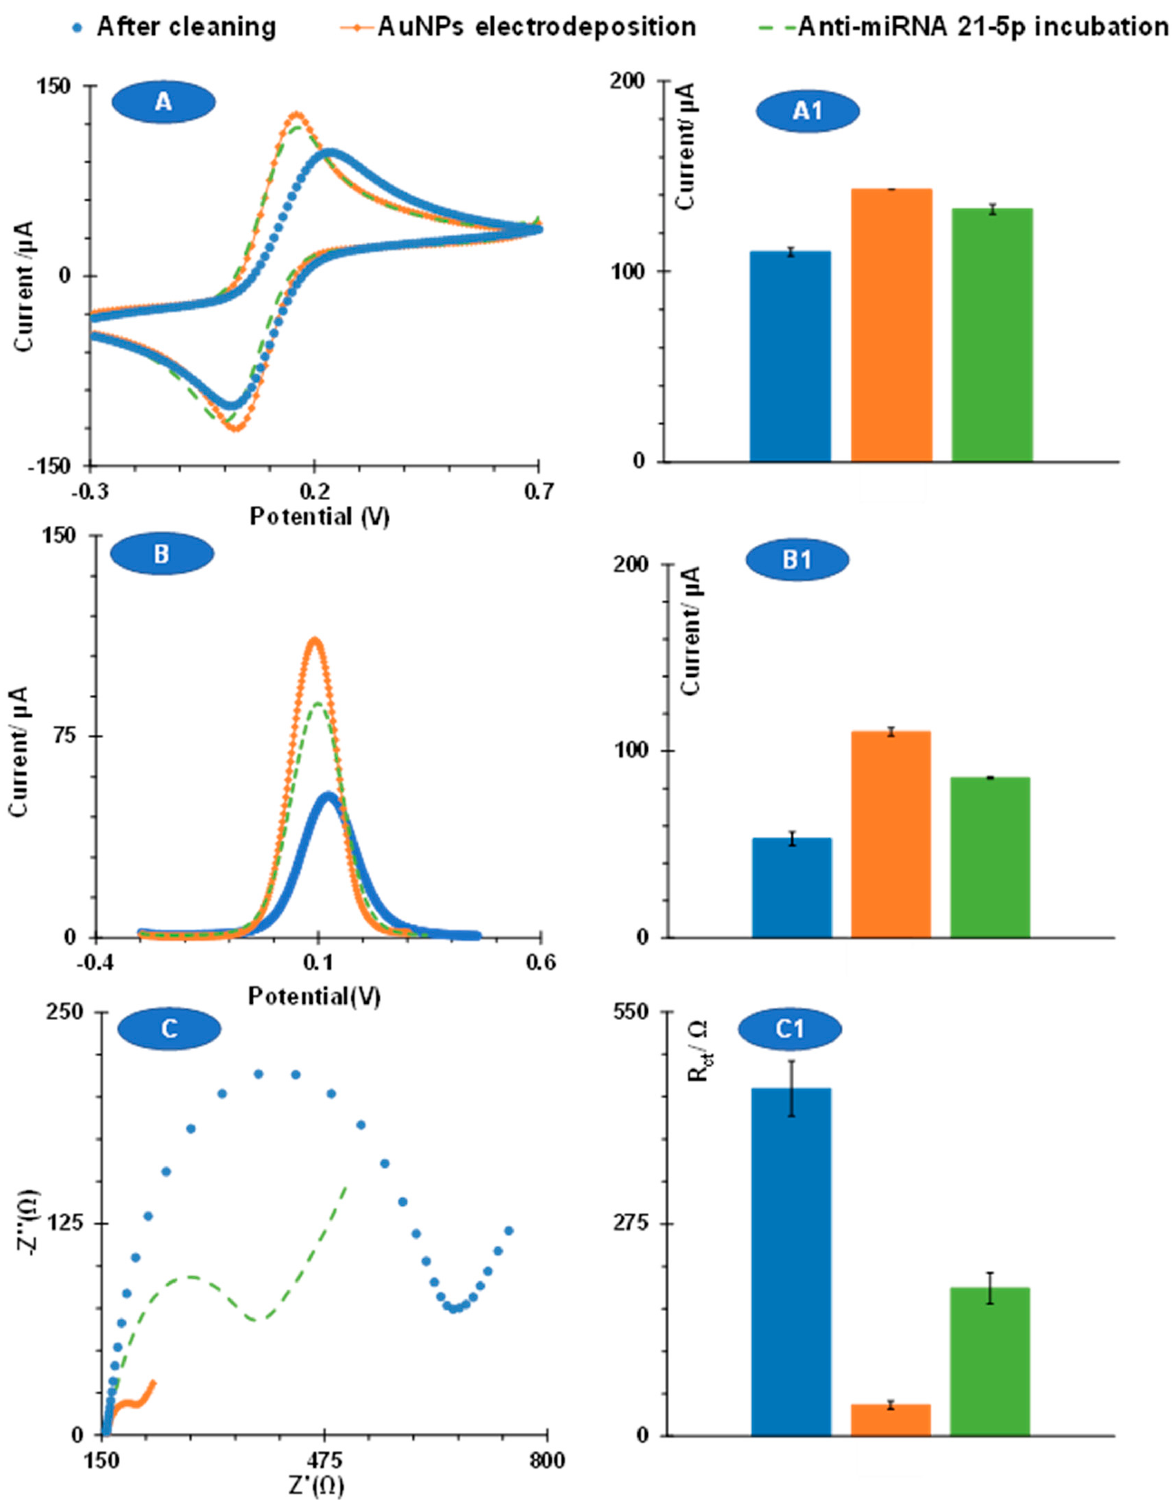
Figure 2. CV ( A ), SWV ( B ), and EIS ( C ) measurements of the devices at the several stages of the biosensor assembly, including the pre-treatment process, after AuNPs electrodeposition, and after incubation of miRNA21-5p and MSA. Graphics A and B show current peak intensity and C the resistance to charge transfer, all of these represented in the corresponding graphics (1).